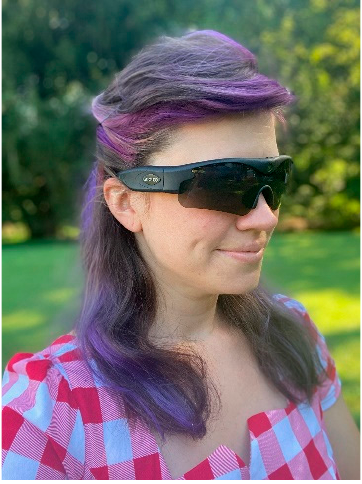
Figure 1. Gogloo E7 SMART wearable video device used in the current study.